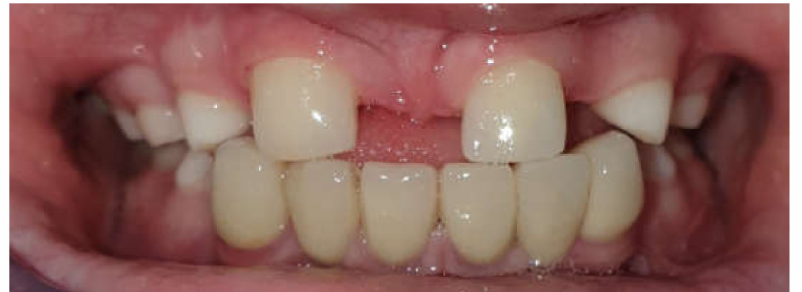
Figure 3. Porcelain teeth restoration 43–33. Post-operative, 36 months’ follow-up.